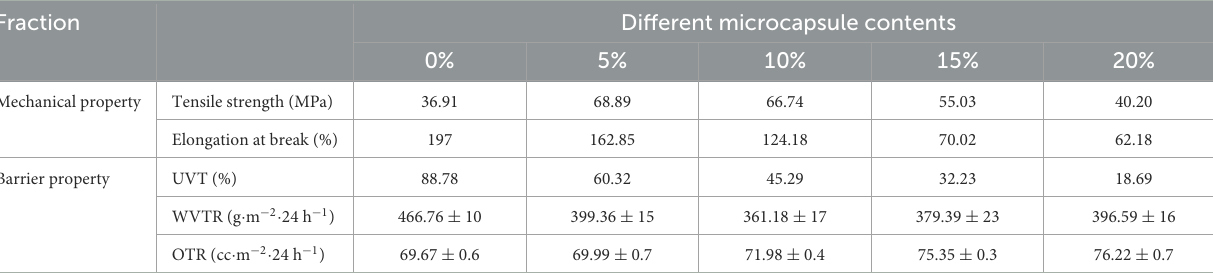
TABLE 1 Effect of different microcapsule contents on mechanical properties, barrier properties, and antibacterial properties of PVA film.